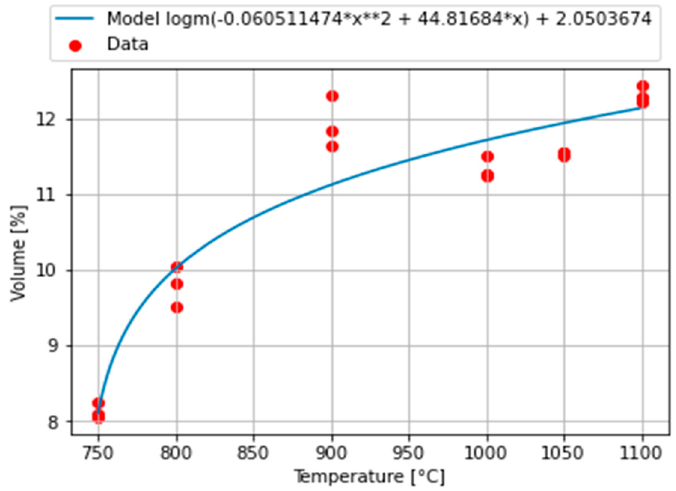
Figure 7. Model 2 of carbon dioxide CO 2 .